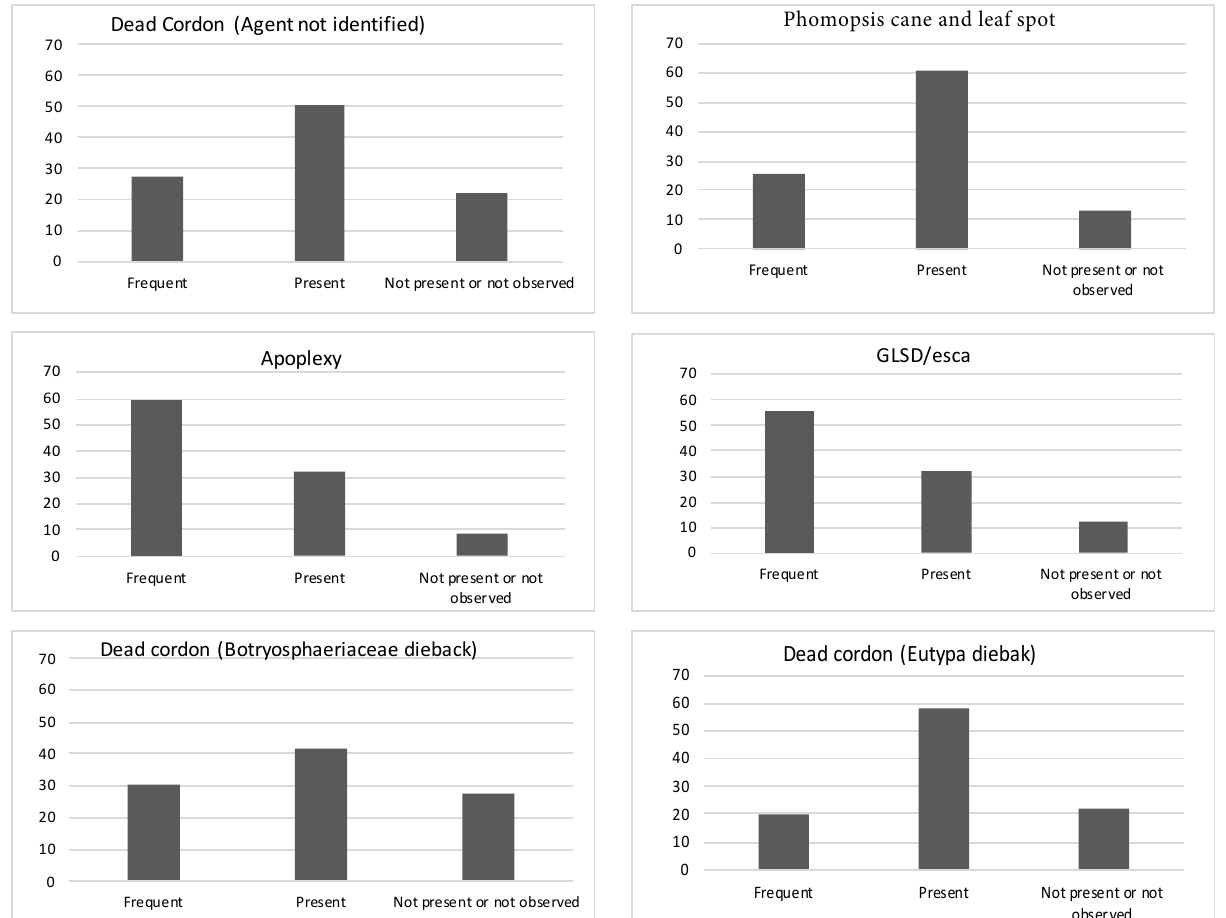
Figure 3. Reports (%) for all surveyed countries of the different GTDs on adult